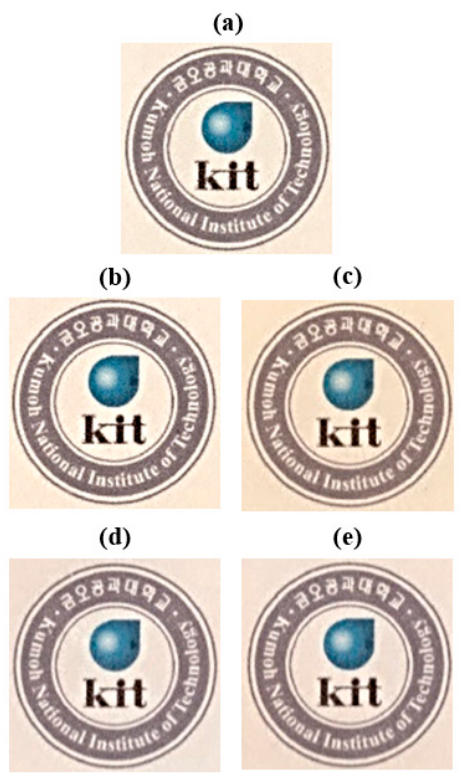
Figure 12. Photographs of PI hybrid films with BAS-OH monomer containing. ( a ) 0 (pure PI), ( b ) 0.25, ( c ) 0.50, ( d ) 0.75, and ( e ) 1.00 wt% of Cloisite 30 B.